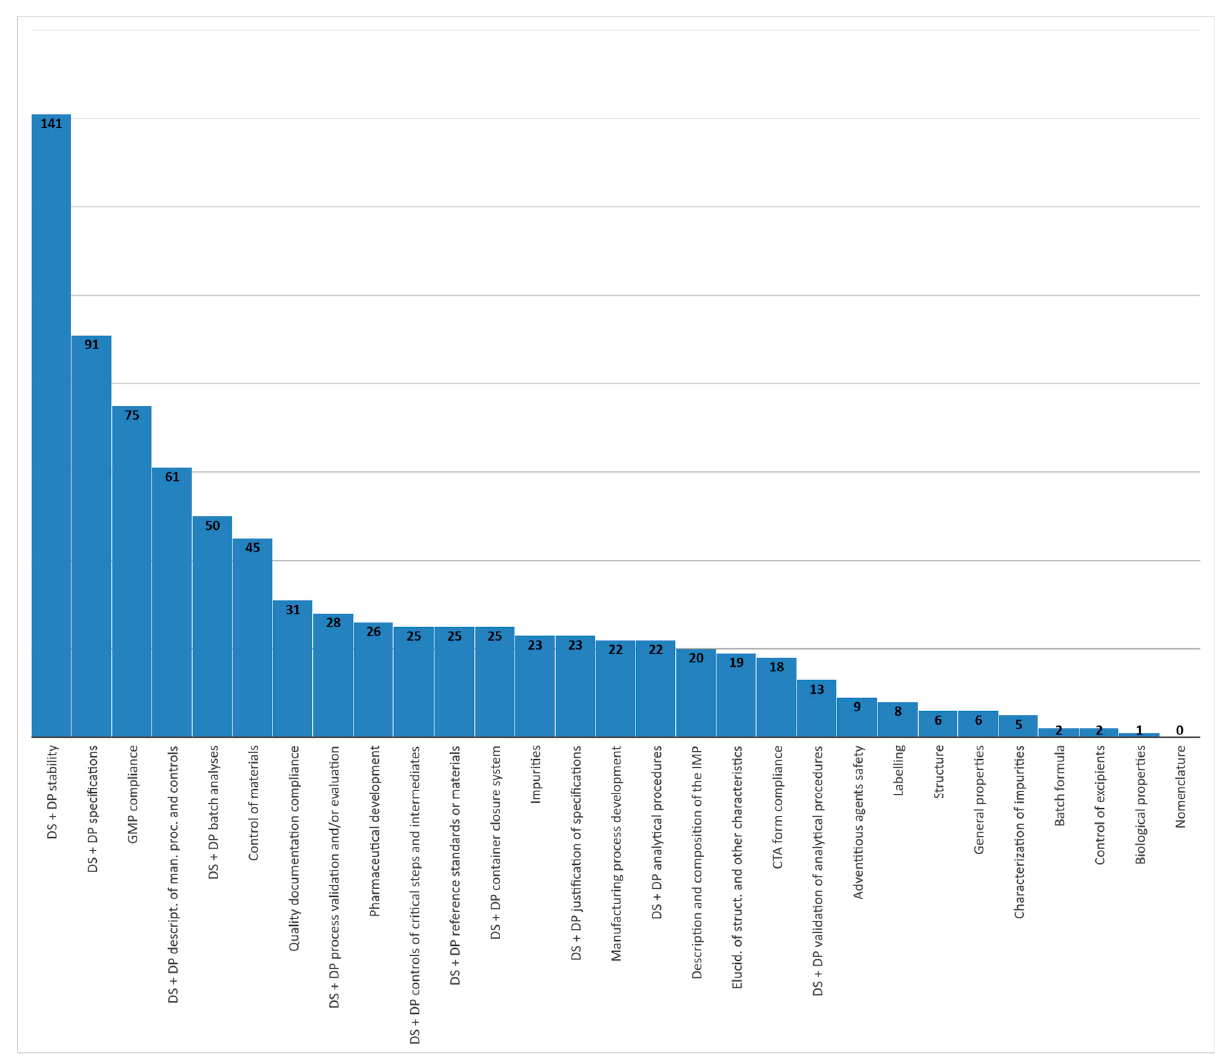
Figure 5. Number of quality issues combining drug substance (DS) and drug product (DP) classification label in CTs involving nanomedicines, assessed and authorized from 2018 to 2020.